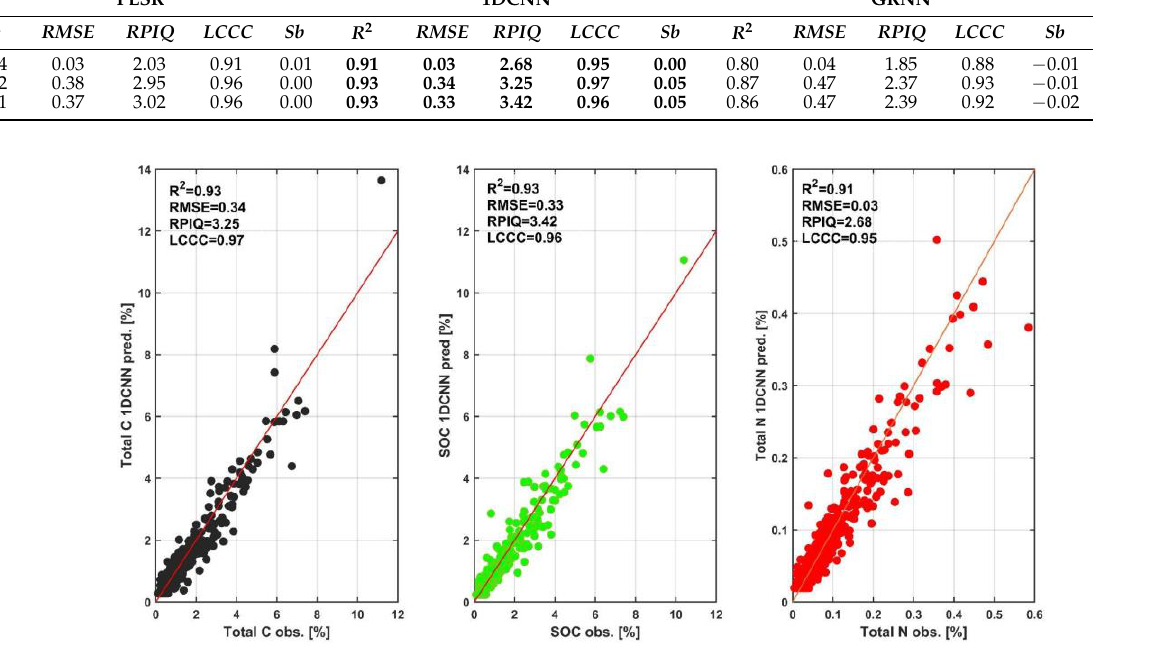
Figure 4. Scatter plots of C and N content prediction validation data using the 1DCNN model. When the points are on the red line it is an indication of perfect prediction, deviations from red line indicate prediction errors.